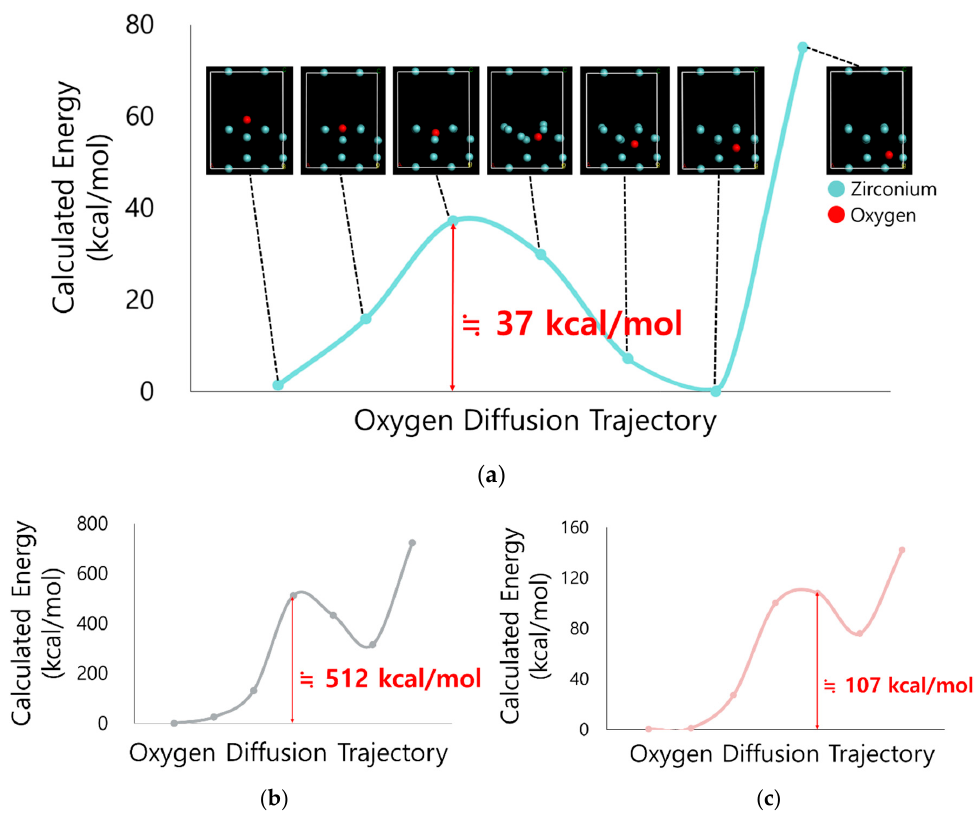
Figure 5 . Calculated energetics for oxygen penetration into the inside of Zr ( a ), TiH 2 ( b ), and B ( c ). Figure 5. Calculated energetics for oxygen penetration into the inside of Zr ( a ), TiH